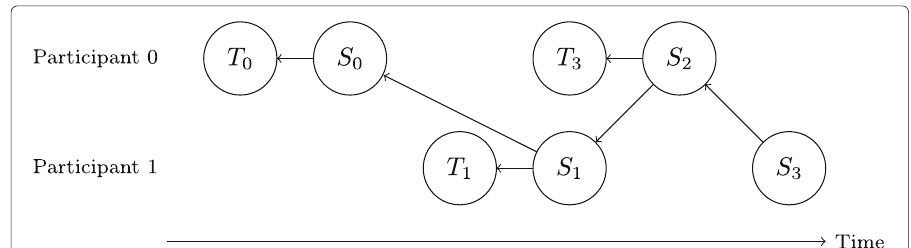
Fig. 4 Exemplified run of the optimization protocol. Two participants send transactions T 0 to T 3 and propose corresponding solutions S 0 to S 3 . Both participants finally agree on solution S